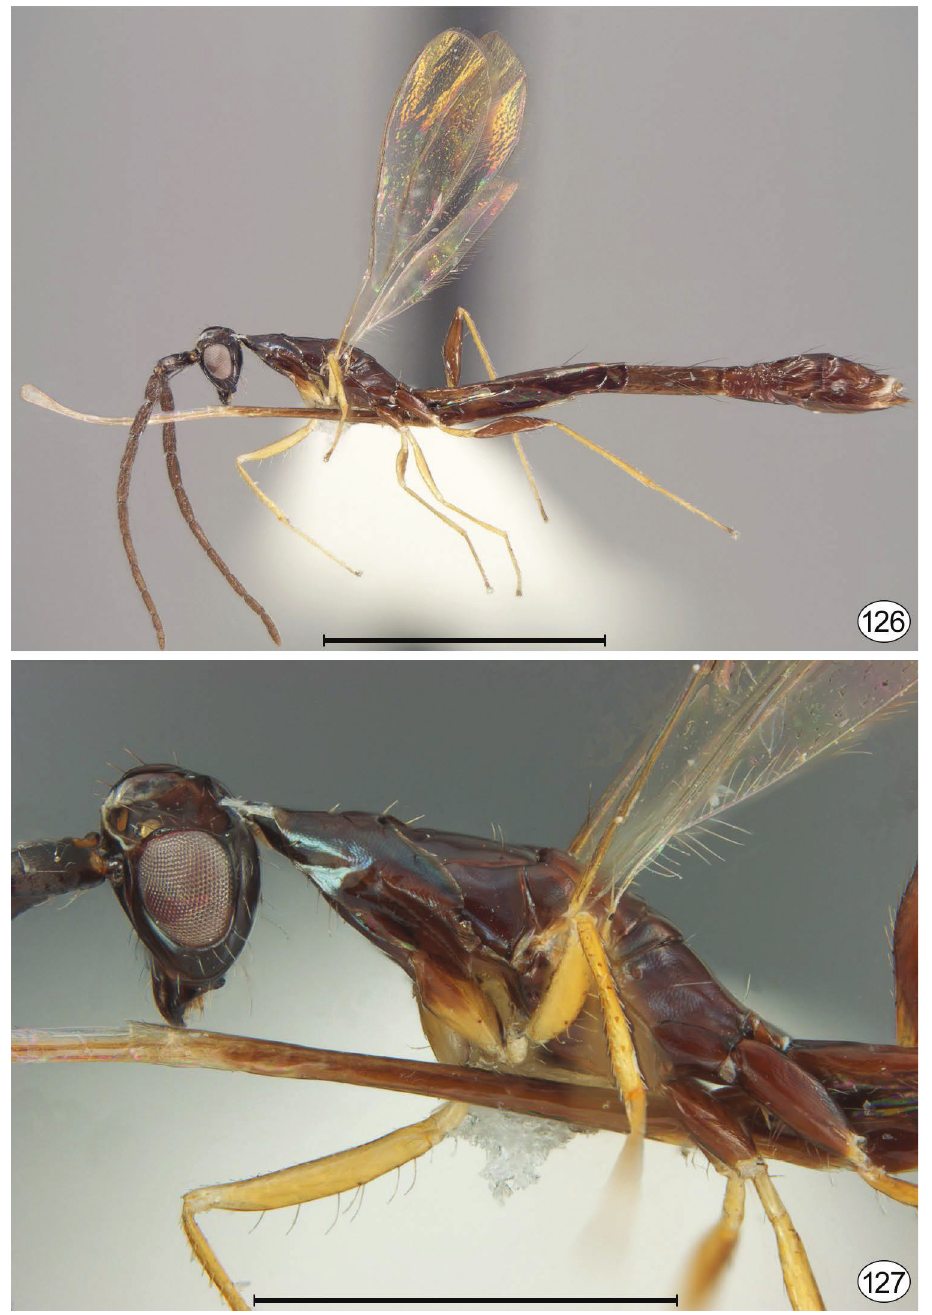
Figures 126, 127. Neotriadomerus longissimus , paratype, lateral (Brisbane Forest Park). 126 habitus, lateral 127 anterior body, enlarged. Scale bar for 126 = 2000 μm; 127 = 1000